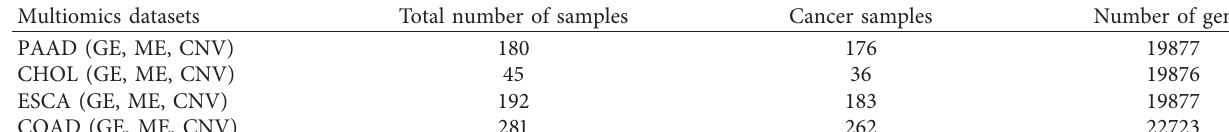
Table 2: Overview of multiomics datasets.